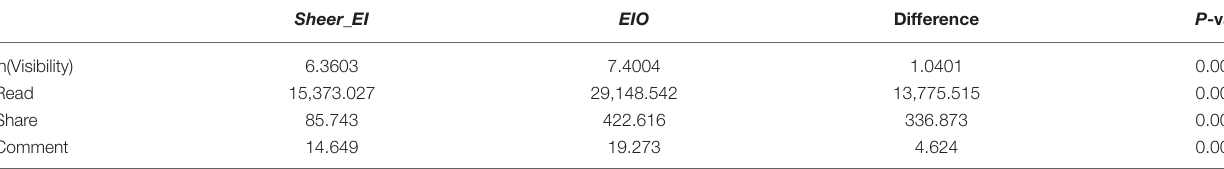
TABLE 4 | Means of the visibility metrics in both Sheer_EI and EIO